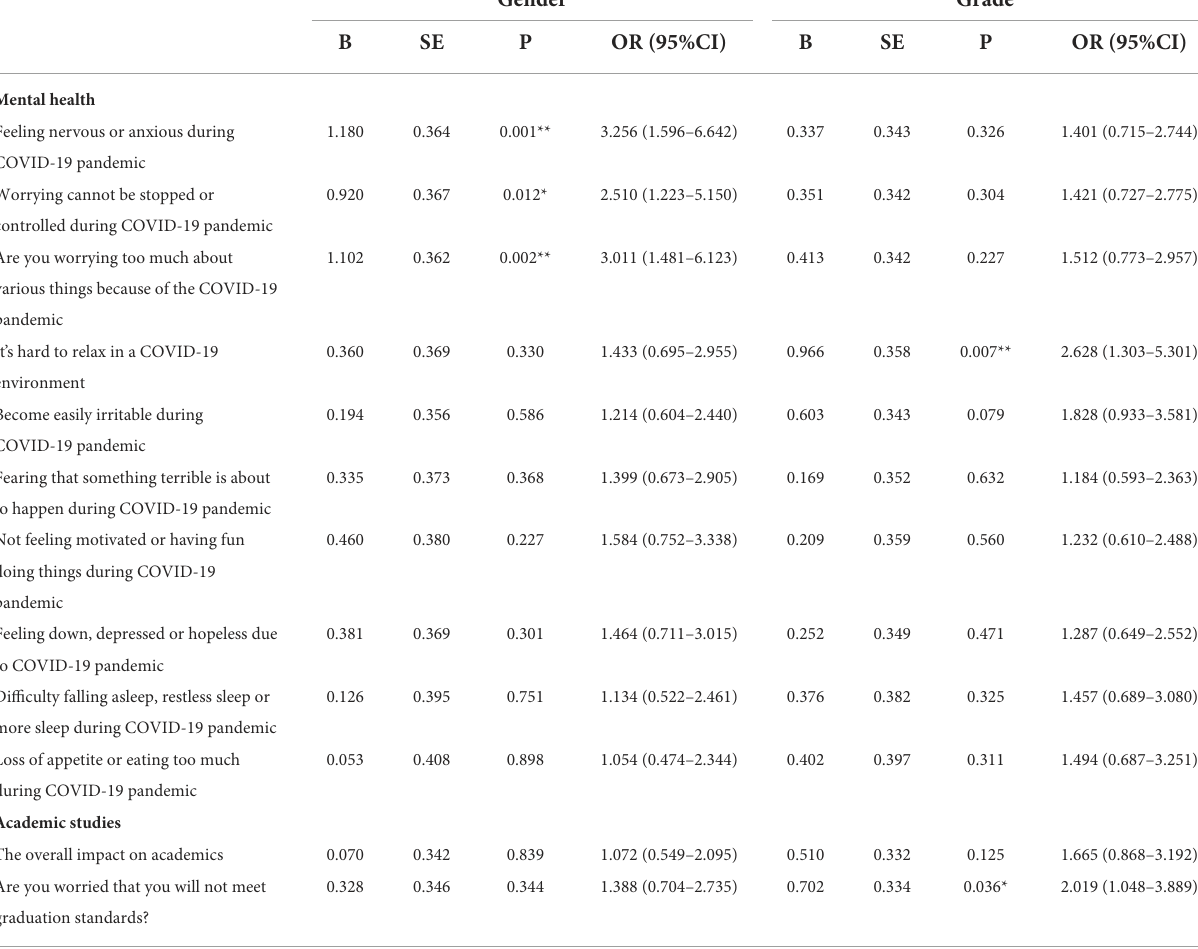
TABLE 9 Multivariable logistic regression of factors influencing mental health and academic